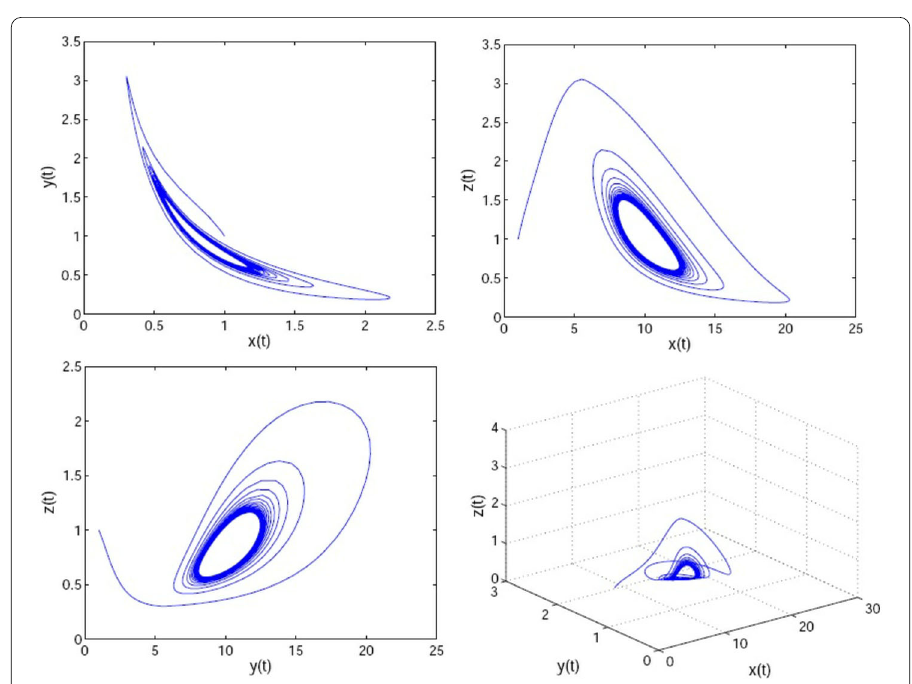
Figure 8 The phase plots of system (32). It is unstable when τ = 6.5 > τ 0 =